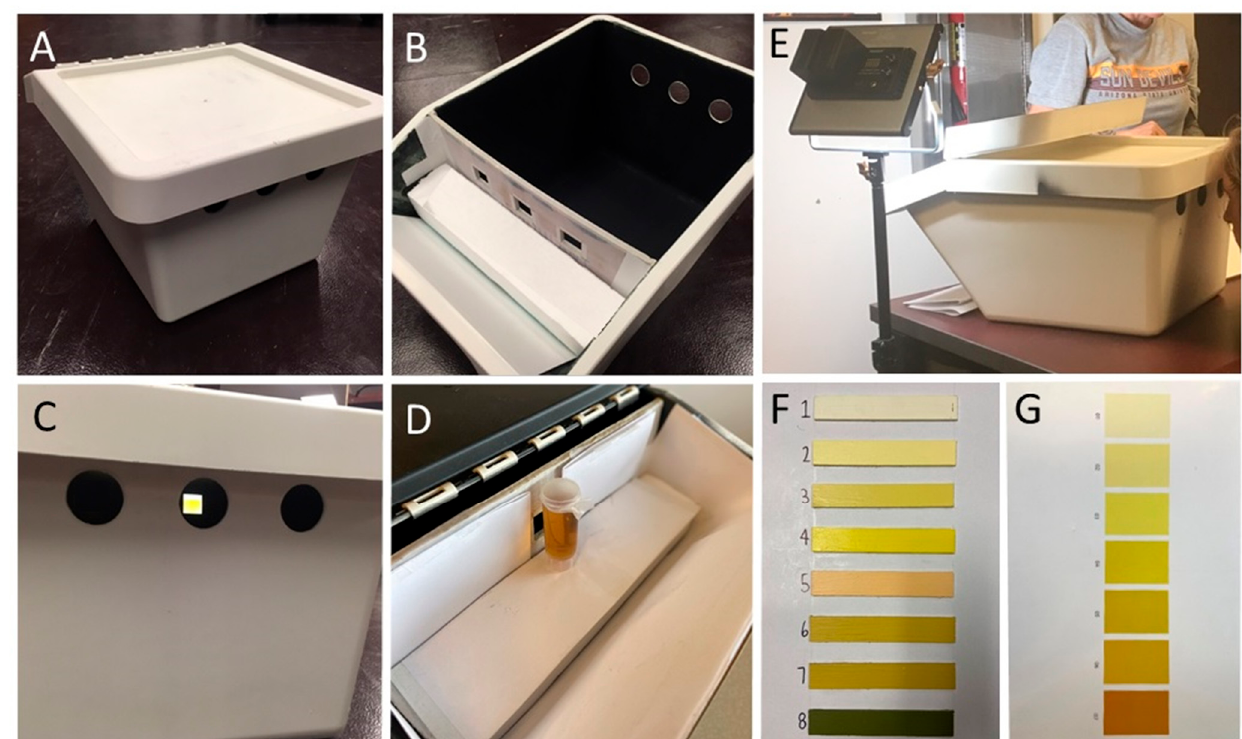
Figure 1. Urine color scoring box and pictures of the Uc charts used during this study. ( a ): The box (Sortera 37.9 L (10 gal), IKEA, Almhult, Sweden) was converted to score urine samples by adding three holes in the front; ( b ): The box was painted black and a white wall was positioned at the end of the box, with three square holes of 2.2 × 2.2 cm (1 × 1 inch) in it; ( c ): For the purpose of this study, only the middle hole was used to score one urine sample at a time while the other holes were covered; ( d ): The urine sample, covered with transparent foil, was positioned behind the middle square hole in front of a white backdrop while the left and right squared holes were covered; ( e ): Athletes were seated while scoring the urine sample, with the sample lighted from the left site using a 28-watt color adjustable lamp providing an intensity of ~1650 lux at full power and light color set to white (NL480, Neewer, Shenzen, China) while color charts are on the right of the scoring box; ( f ): A picture of the 8-color Uc chart remake with colors adapted from Armstrong et al. (1994); ( g ): A picture of the 7-color Uc chart developed by Wardenaar and Bacalzo in 2019.